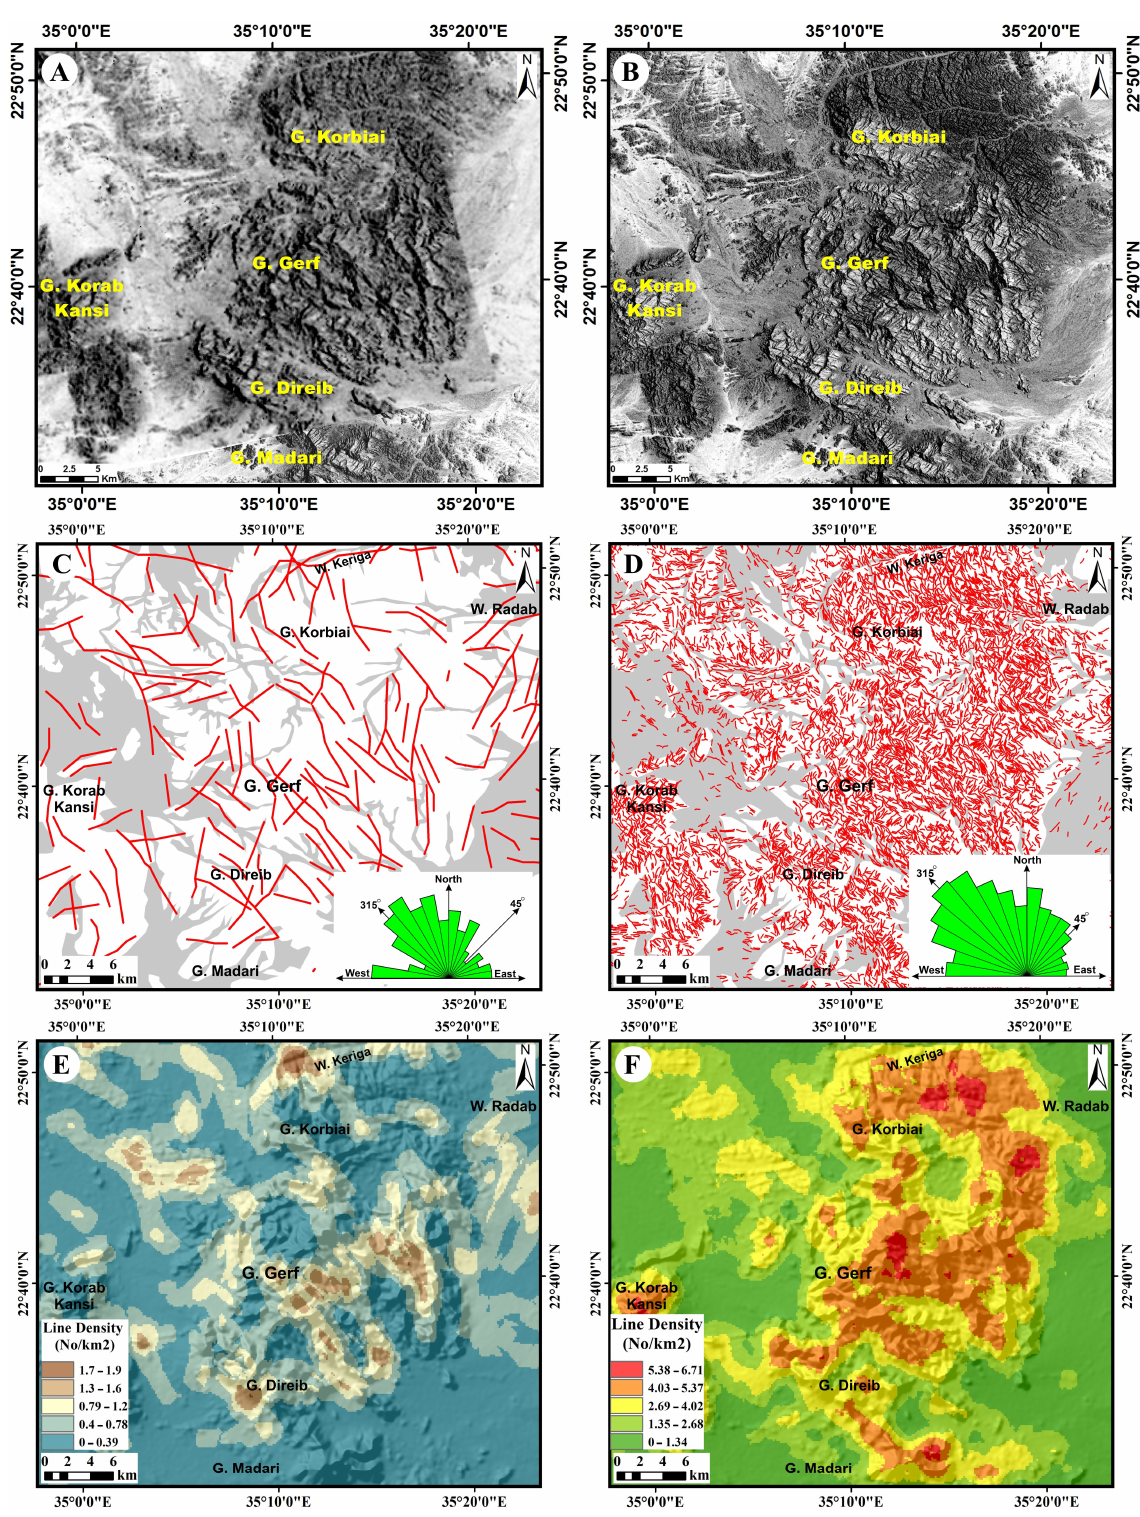
Figure 11. Lineaments extraction ( A ) PC1 of PALSAR, ( B ) PC1 of Sentinel-1B, ( C ) Lineaments map from PALSAR, ( D ) Lineaments map from S1B, and ( E , F ) Lineaments density map of PALSAR and S1B,